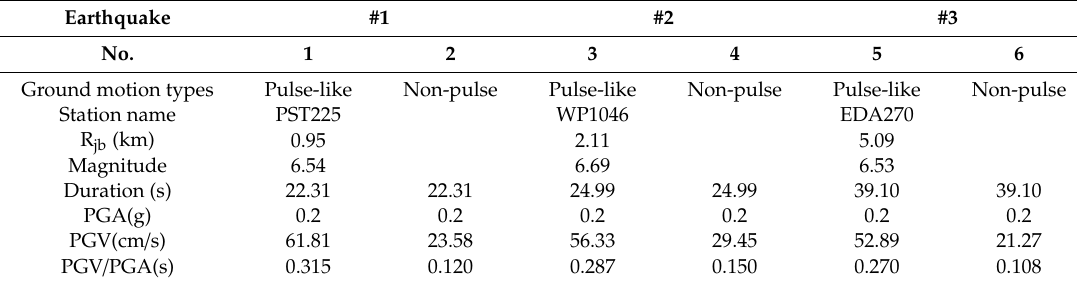
Table 1. Properties of the near-fault pulse and non-pulse seismic